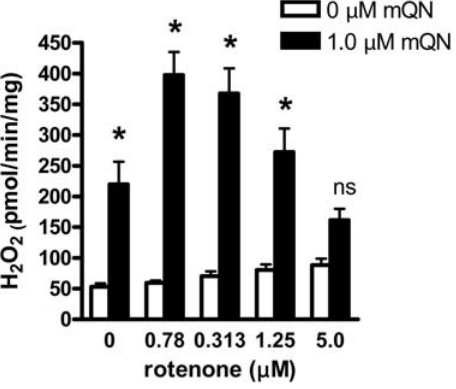
Figure 4. Interactive effect of rotenone and mitoquinone on H 2 O 2 production by BAE mitochondria fueled by 5 mM glutamate plus 1 mM malate incubated in respiratory buffer under state 4 conditions. Mitochondria were exposed to mitoqui- none (mQN) and/or rotenone at the concentrations indicated. Data represent mean 6 SE, n=4 for each data point. * p , 0.001 or non- significant (ns) compared to 0 m M mQN by 2-way ANOVA (factors are mQN and rotenone). There was significant interaction (p , 0.001) between factors indicating the effect of mQN is dependent on the